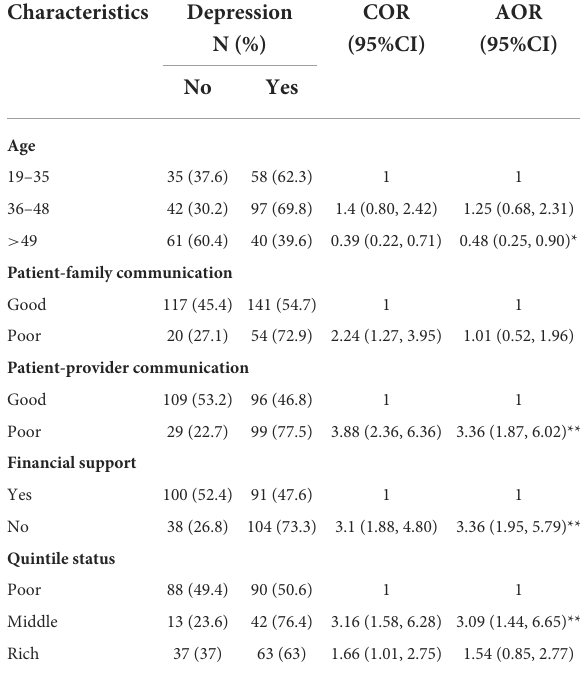
TABLE 3 The result of logistic regression for anxiety after controlling the effect of confounding factors among patients with breast cancer. Characteristics